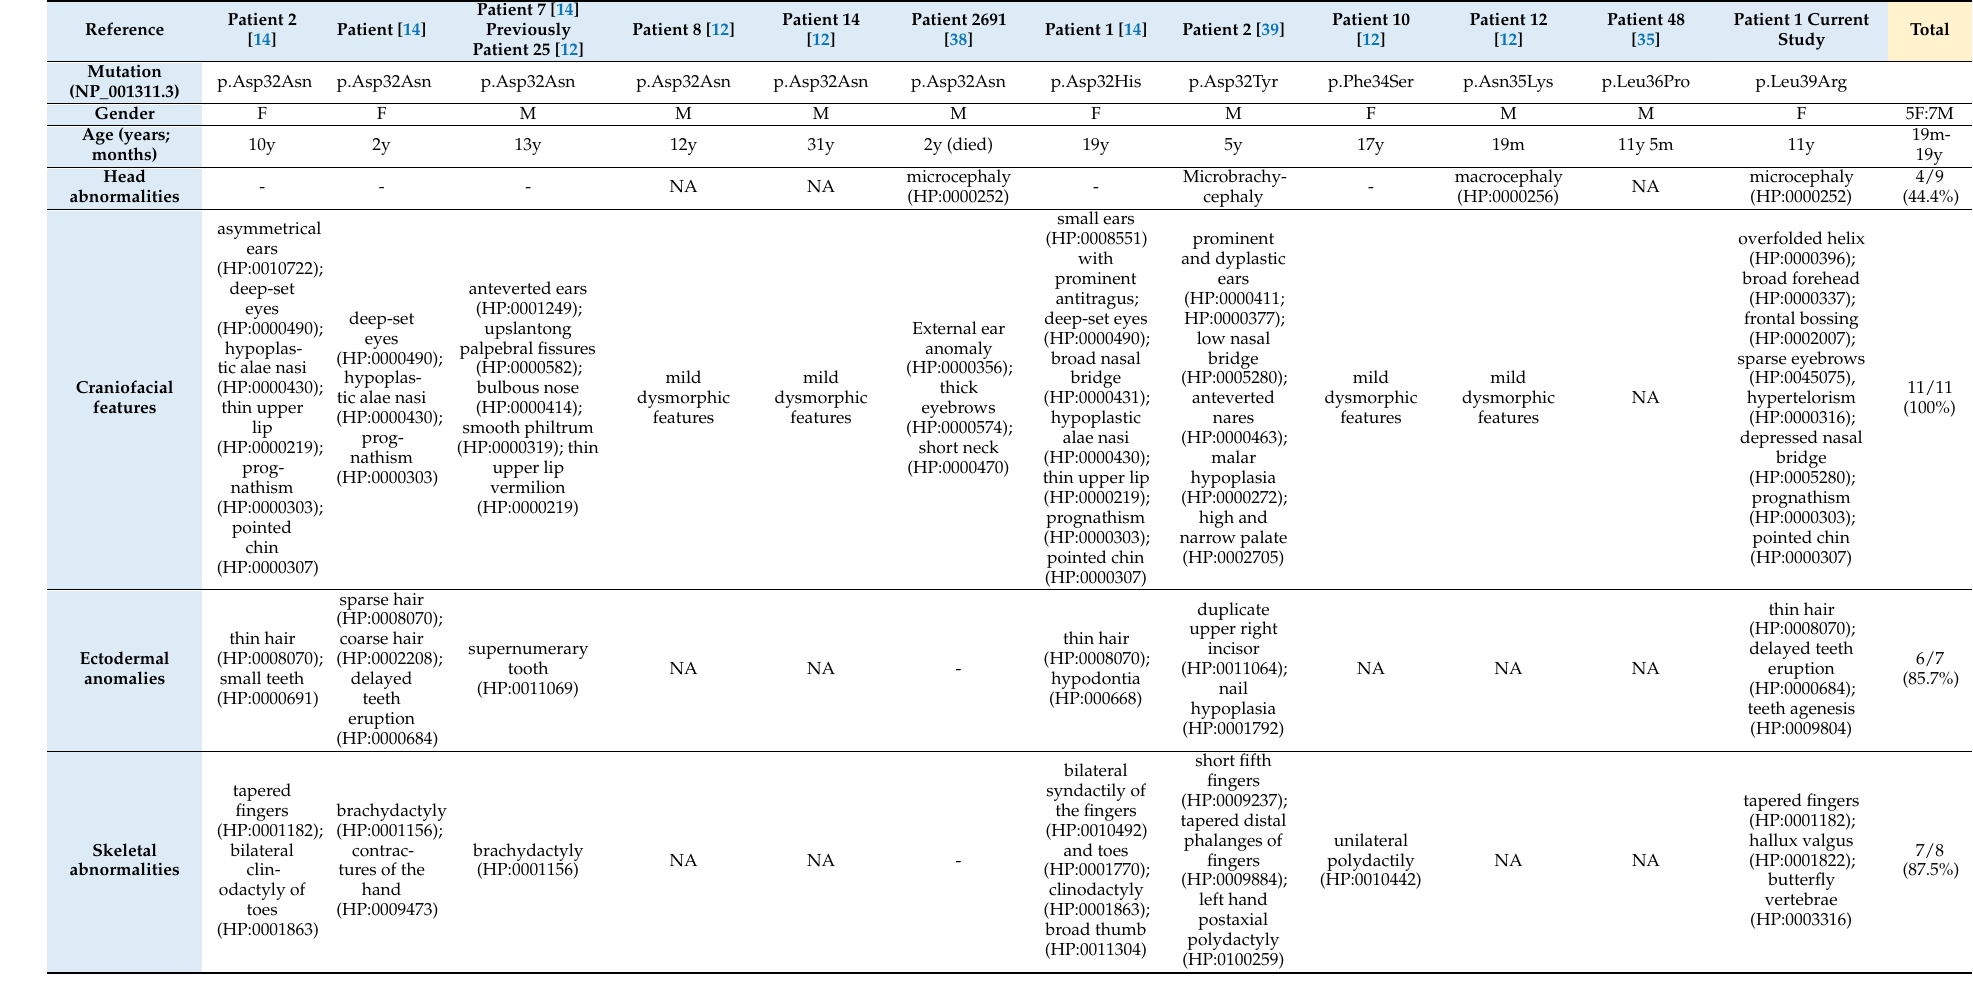
Table 2. Main clinical features of the patients with CSNK2B missense mutations affecting the KEN box-like. +: present; - not present; NA: not